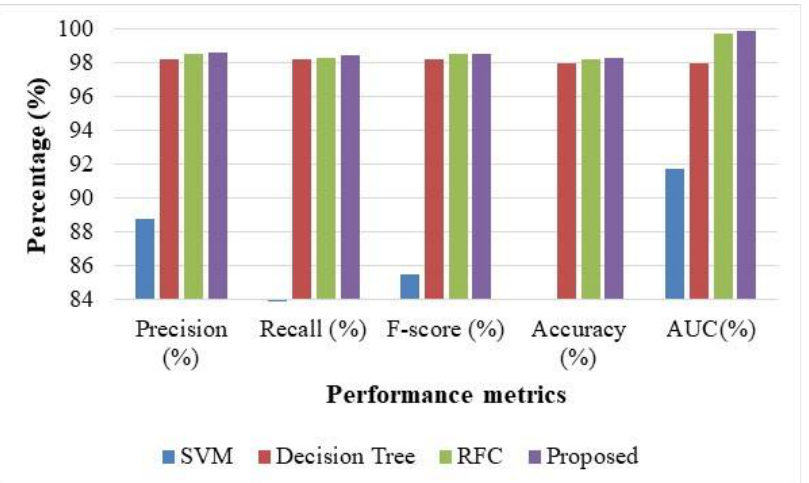
Figure 5. Evaluation of performances for the SVM, DT, RFC, and the proposed method for the NSL-KDD dataset.